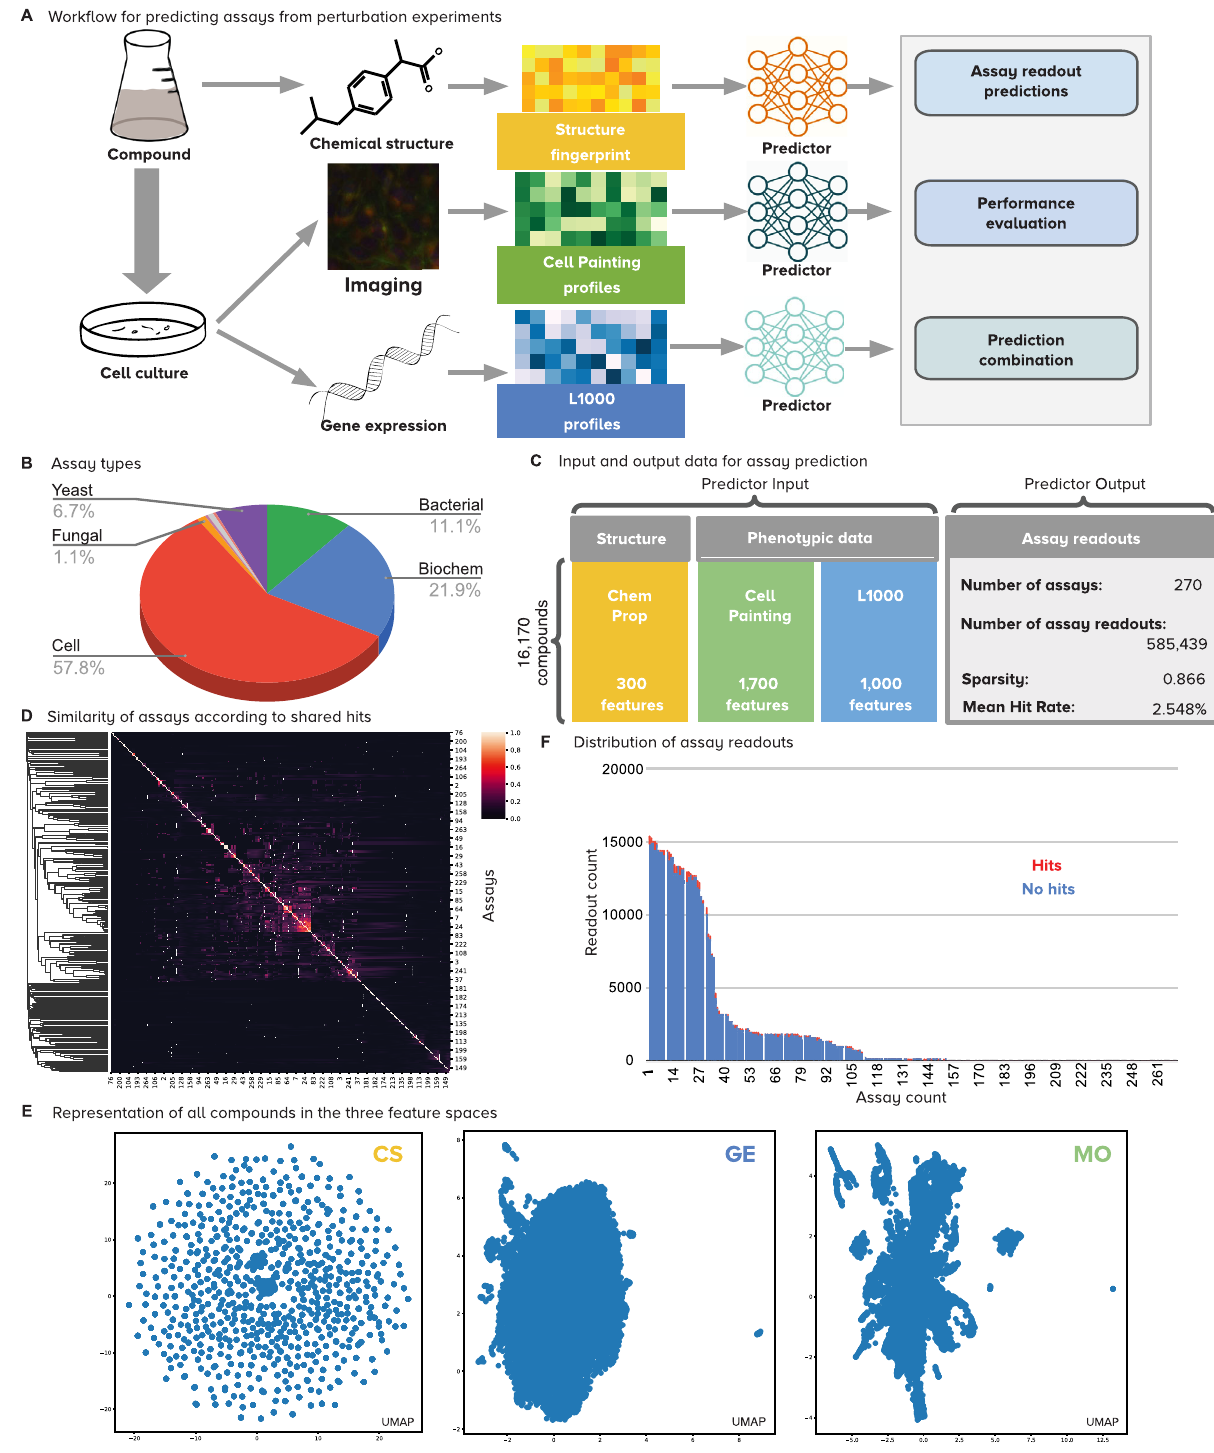
Fig. 1 | Overview of the work fl ow and data. A Work fl ow of the methodology for predicting diverse assays from perturbation experiments (more details in Supple- mentary Figs. 1 and 2). B Types of assay readouts targeted for prediction, which includea totalof eight categories (Supplementary Fig.15). C Structureof the input andoutputdataforassayprediction. D SimilarityofassaysaccordingtotheJaccard similarity between sets of positive hits. Most assays have independent activity